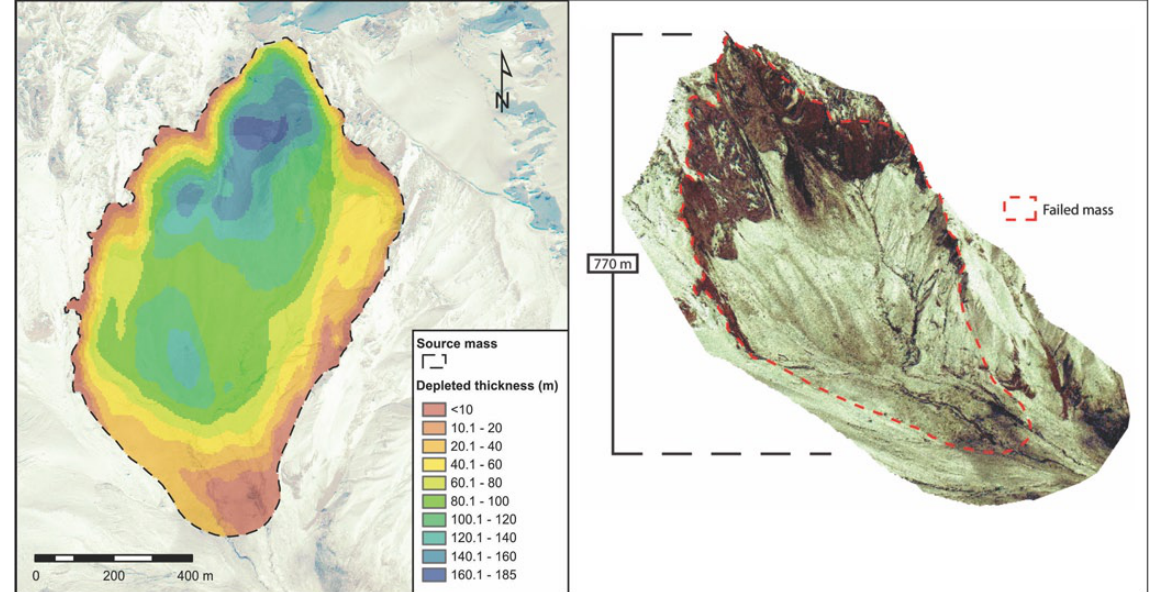
Fig. 5. The difference in depth between the TRIM (before) and GeoEye DEMs used to calculate volume. The strong lateral shears, high backscarp and bulge of the pre-failure flank are all readily interpreted from the differencing map. The landslide outline was accurately delineated based on new imagery (right side of figure). The total calculated volume is 48.5 × 10 6 m 3